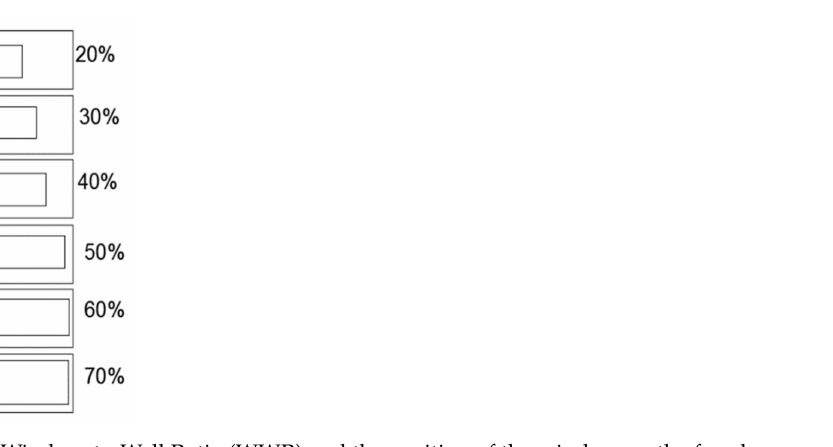
Figure 3. Window-to-Wall Ratio (WWR) and the position of the window on the façade. Three different window types were considered; BESTEST (2/air), two-pane window with Argon between the panes (2/Arg), and three-pane window with air between the panes (3/air). Each window’s specifications are shown in Table